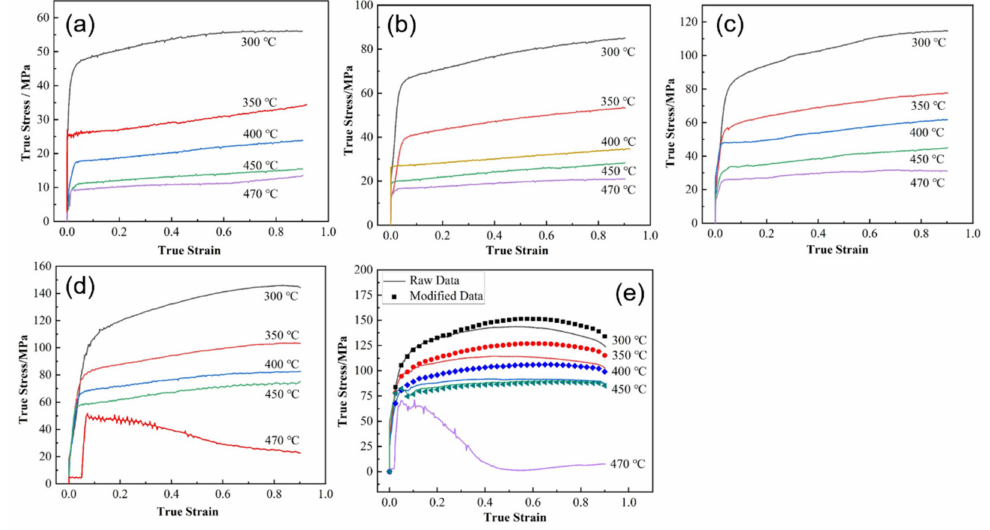
Figure 1. True stress-true strain curves under different strain rate and temperature conditions (Data are corrected based on deformation temperature rise effects for 5 s − 1 compressed samples) ( a ) 0.001 s − 1 ; ( b ) 0.01 s − 1 ; ( c ) 0.1 s − 1 ; ( d ) 1 s − 1 ; ( e ) 5 s − 1